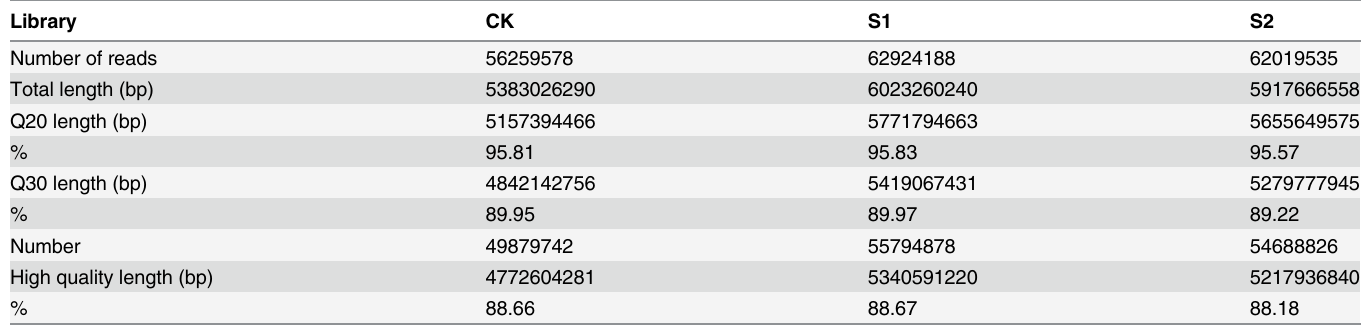
Table 1. The whole sequencing statistics for Kosteletzkya virginica